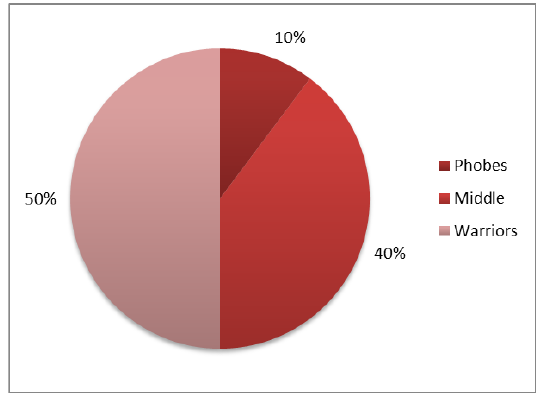
Fig. 2. Distribution of students self- confidence in Programming